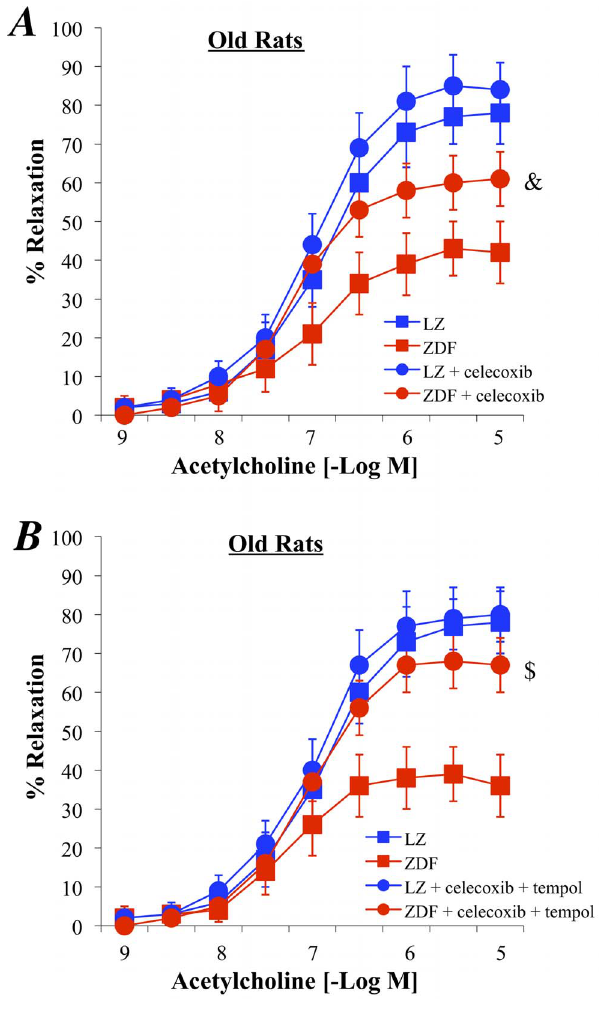
Figure 7. Effect of a chronic treatment of old LZ and ZDF rats with celecoxib (A) or with the combination of celecoxib and tempol (B) on acetylcholine-induced relaxation of isolated mesenteric resistance arteries. Mean 6 SEM is presented (n=8 per group). & P , 0.05, effect of celecoxib alone on acetylcholine-induced relaxation. $ P , 0.05, effect of celecoxib + tempol on acetylcholine- induced relaxation.